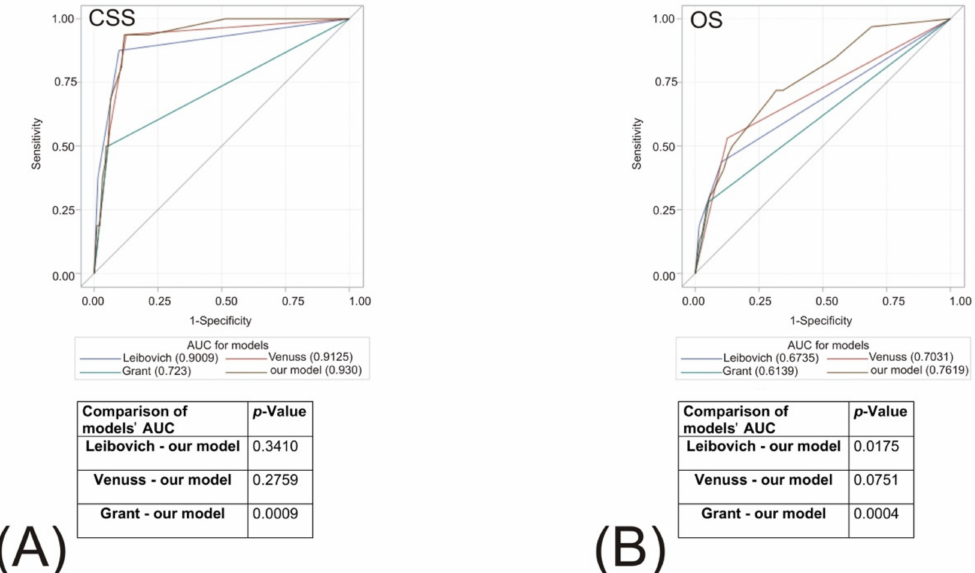
Figure 3. External validation of the previously established risk models: Leibovich, VENUSS and GRANT and comparison with our model. ROC curves for all the models were shown in different colors, representing prognostic values of the respective models for overall survival ( A ), and cancer- specific survival ( B ) (c-indexes of the models were provided in brackets). Additional collation with our model was presented with the respective p